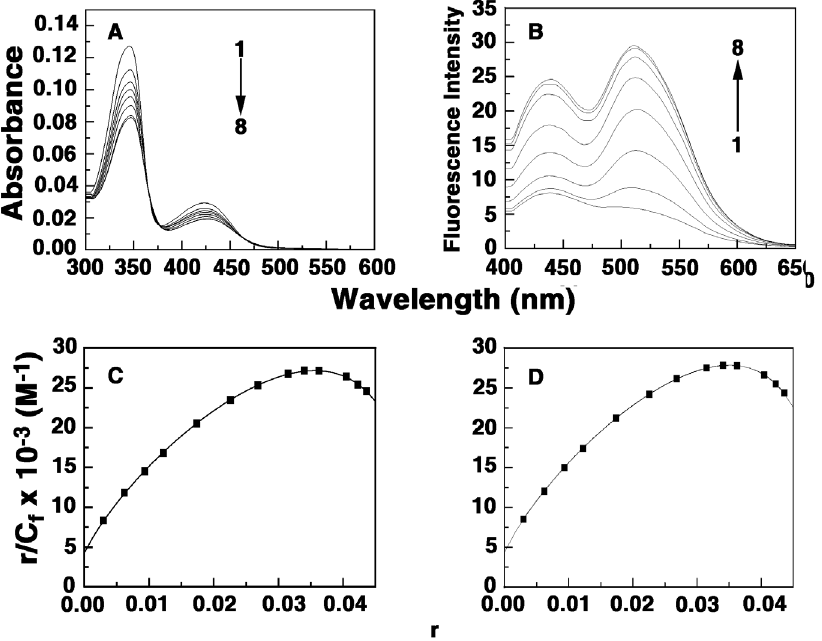
Figure 2. Absorption and fluorescence spectral studies of the analogs with tRNA. (A) Absorption spectral changes of analog B4 (curve 1) with increasing concentration of tRNA (curves 2–8), (B) fluorescence spectral changes of analog B4 (curve 1) with increasing concentration of tRNA (curves 2–8) (C) Scatchard plot for analog B4-tRNA complexation from absorbance and (D) Scatchard plot for analog B4-tRNA complexation from fluorescence.